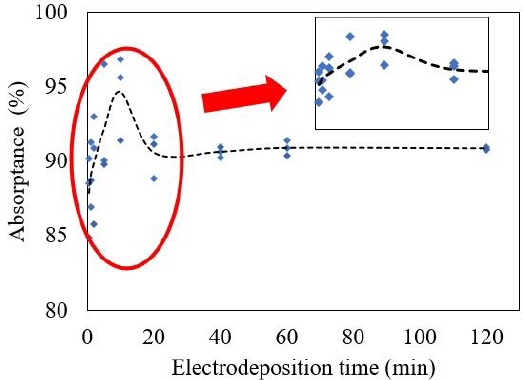
Figure 2. Global absorptance of all samples. Short time samples highlighted.